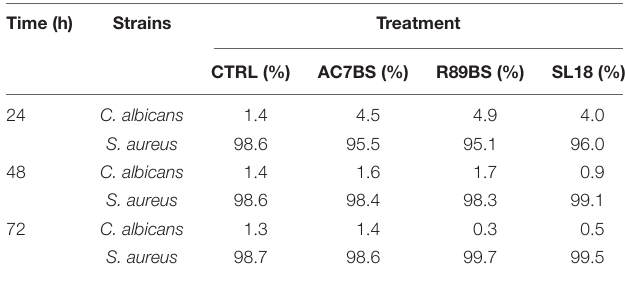
TABLE 3 | Percentage (%) composition of C. albicans – S. aureus dual-species biofilms on the surface of silicone discs. Time (h) Strains Treatment